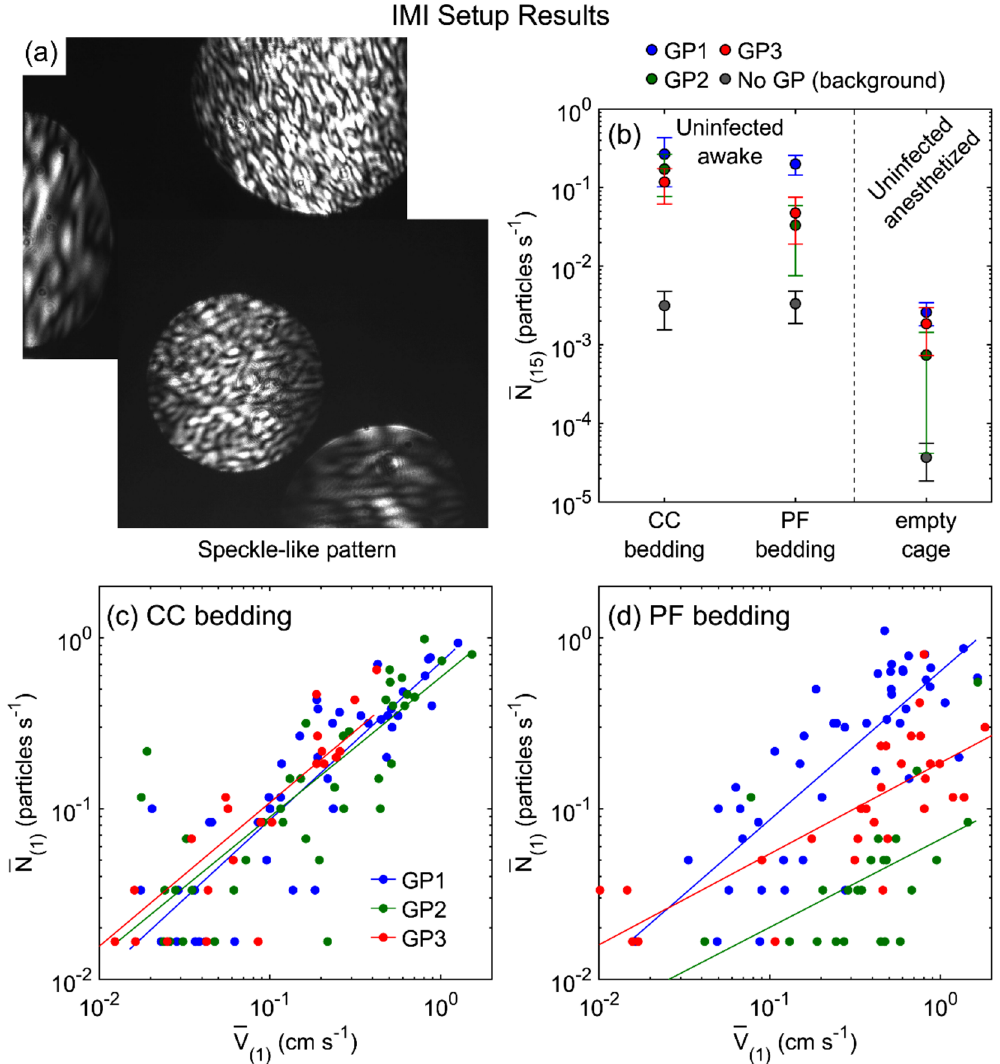
Figure 2. Particle emission rates measured by IMI setup. ( a ) Images captured by CCD camera that show speckle-like pattern for particles illuminated by the laser sheet. ( b ) Time-averaged particle emission rate, N ( 15 ) for three guinea pigs (GP1, GP2, and GP3) under different conditions: uninfected, awake guinea pig in the cage with CC bedding or PF bedding, and uninfected, anesthetized guinea pig inside the empty cage. A plastic bag was used to cover anesthetized guinea pig fur with a small opening for its nose facing directly toward the laser sheet. Background particle measurements for each condition where no guinea pig was in the cage are shown with gray circle markers (No GP (background)). Each data point is the average of four 15-min time-averaged particle emission rates and 3 trials for each guinea pig. Time-averaged particle emission rate, N ( 1 ) versus time- averaged guinea pig movement velocity, V ( 1 ) over 1 min, for three uninfected guinea pigs in the cage with ( c ) CC bedding, and (d) PF bedding. Solid lines are best power law fits (see Table S1 for